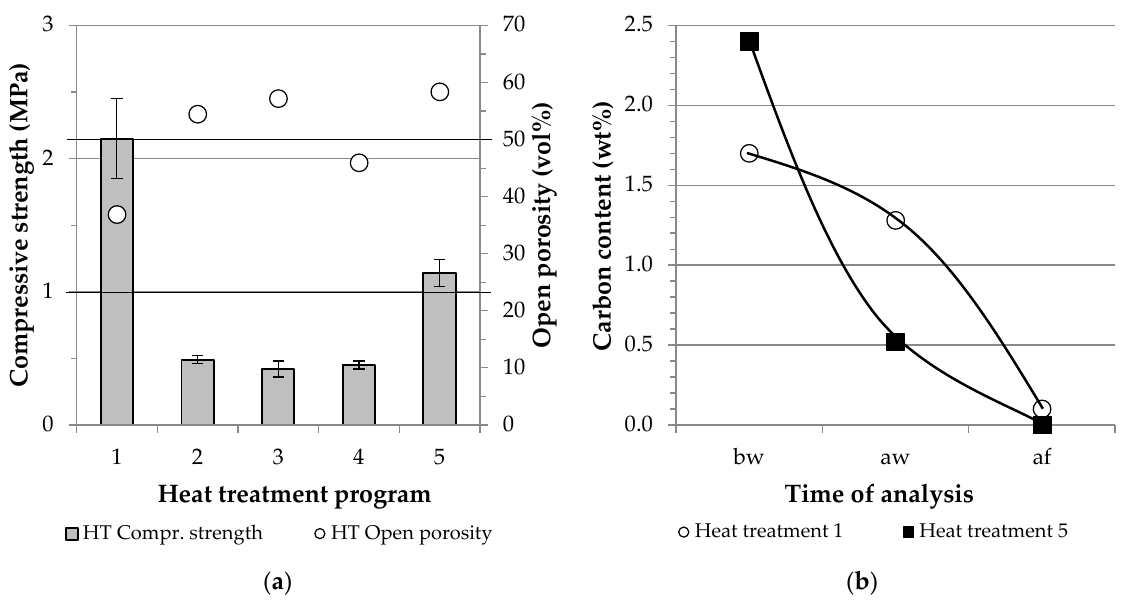
Figure 10. Effect of heat treatment conditions on ( a ) the compressive strength and apparent porosity and ( b ) organic carbon content (Horizontal lines indicate boundary conditions in the case of the experimental job).